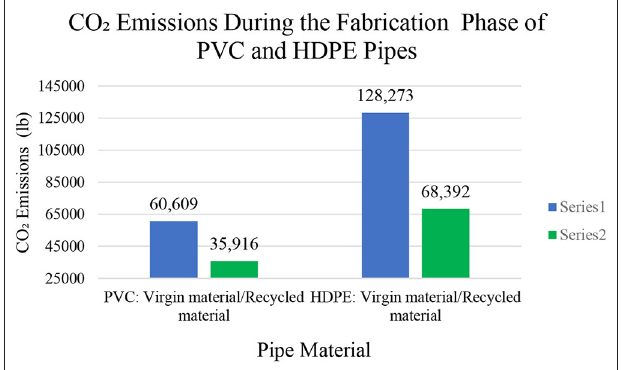
however, when the asphalt pavement is used for repaving the surface, the CO 2 emissions are 23,942 kg (52,784 lb). When the asphalt is used for repaving the surface in the pipe bursting method, the CO 2 emissions are 3,990 kg (8,797 lb), whereas they are only 619 kg (1,365 lb) when using reinforced concrete. For the CIPP method, when the asphalt is used for repaving, CO